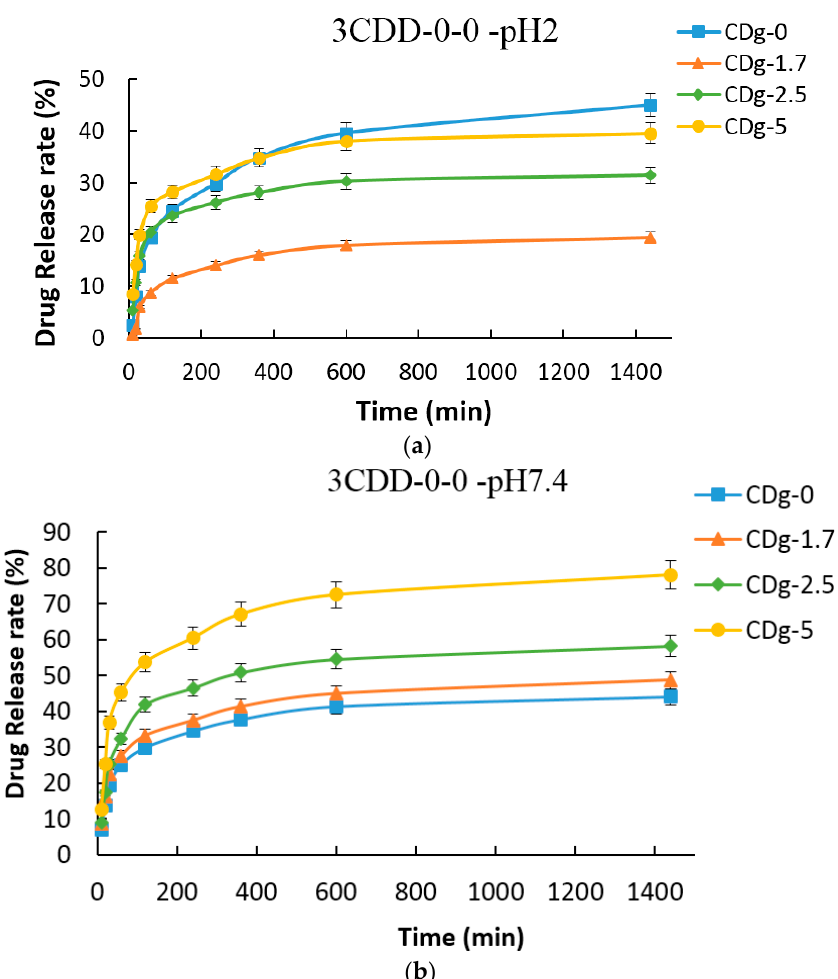
Figure 12. Drug release rates of various hydrogel carriers at 37 °C and: ( a ) pH = 2; and ( b ) pH = 7.4